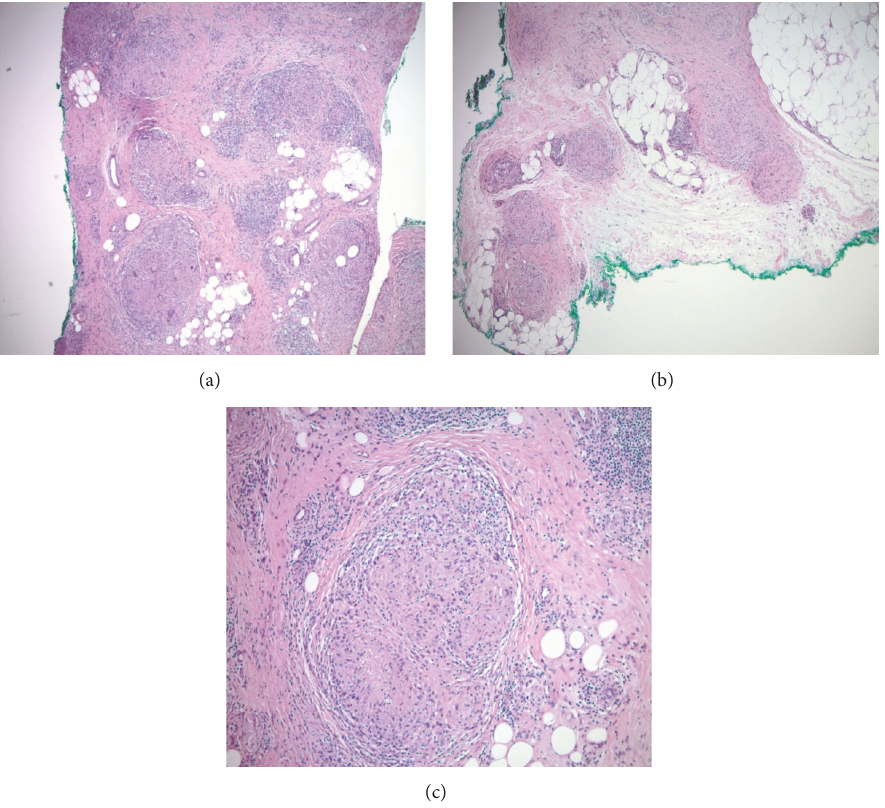
Figure 1: (a), (b), (c). Deep dermal and mainly subcutaneous sarcoidal granulomata characterized by multinodular infiltrate of mono- and multinucleated epithelioid histiocytes with some lymphocytes (hematoxylin-eosin stain, magnifications 10 X, 10X, 20X,